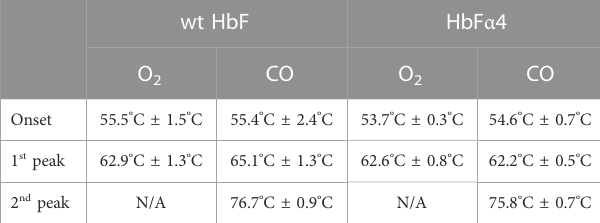
TABLE 2 Thermal denaturation data of wt and mutant HbF as determined by nanoDSF in a Prometheus NT.48 instrument (NanoTemper